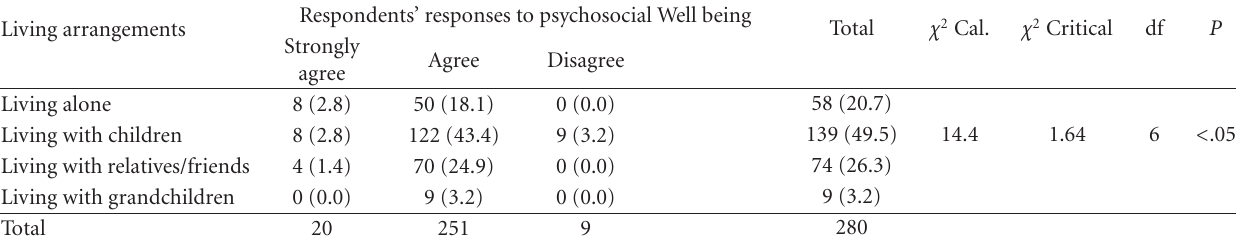
Table 3: Cross-tabulation and chi-square analysis of the living arrangements and psychosocial well being of elderly. Living